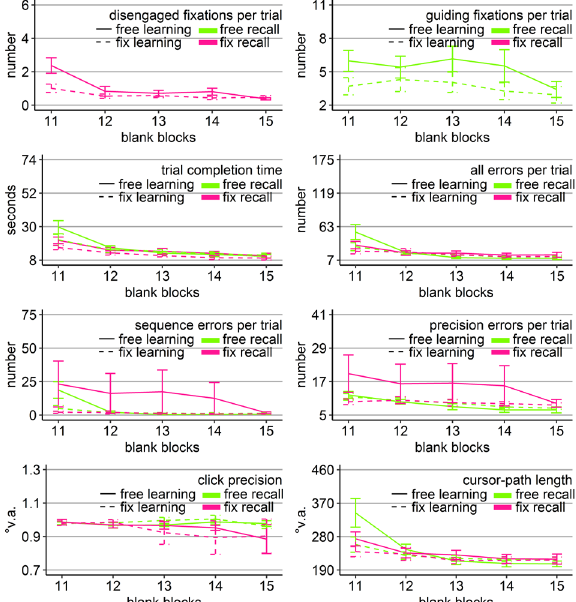
Figure 3. Gaze and performance measures during the recall phase of Experiment 1. The top left plot shows how often participants who were asked to keep central fixation, disengaged their fixation per trial (y-axis) over the course of the five blank blocks (x-axis) depending on whether they learned the clicking sequence with free gaze (solid line) or with fixed gaze (dashed line). The top right plot shows how many guiding fixations participants who were allowed to move their eyes freely performed per trial (y-axis) during the five blank blocks (x-axis) depending on whether they had learned the clicking sequence with free gaze (solid line) or with fixed gaze (dashed line). The six bottom plots show the six performance measures trial completion time in seconds, numbers of all errors, sequence errors, and precision errors per trial, click precision in °v.a., and cursor-path length in °v.a. (y-axes) over the course of the five blank blocks (x-axes) for the four group combinations of recall with free gaze (green lines) or fix gaze (pink lines) after learning with free gaze (solid lines) or fix gaze (dashed lines). Error bars represent standard errors of the